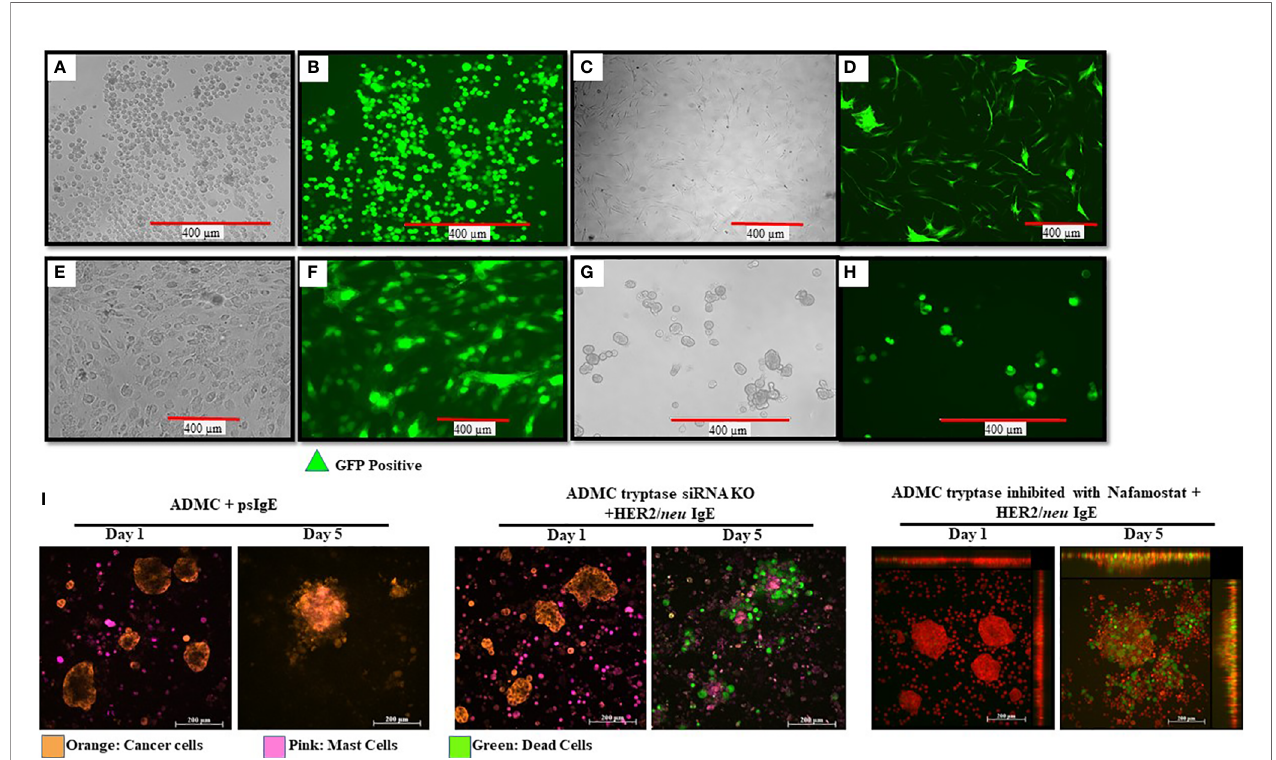
FIGURE 7 | Manipulation of human MCs and adipose stem cells as a platform for increasing safety and cytotoxicity. ADMC ( A, B ; 5x10 6 ) or adipose stem cells ( C, D ; 3x10 6 ) 3 days after infection by 20 m l of GFP-carrying lentiviral particles (4x10 8 Infection Unit). Mag. 20x. Adipose-derived stem cells were transduced with GFP, cryopreserved and reconstituted in stem cell medium (E, F) and GFP fl uorescence. (G, H) Culturing in ADMC medium for 4 months showing ADMC with GFP Mag. 20x. (I) MCs (2x10 5 ) were treated with silencer select siRNA targeting the TPSAB1 gene, sensitized with psIgE or HER2/ neu IgE followed by staining with CellTracker ™ Deep Red. After washing, MCs were added to the pre-stained, adherent BT474 (1x10 5 -8x10 5 ) along with caspase 3/7 and the time lapse video was taken over the indicated times. Image colors were adjusted using AxioVision software where, blue is changed to orange (BT474) and red is changed to pink (MCs). Results are representative of three different